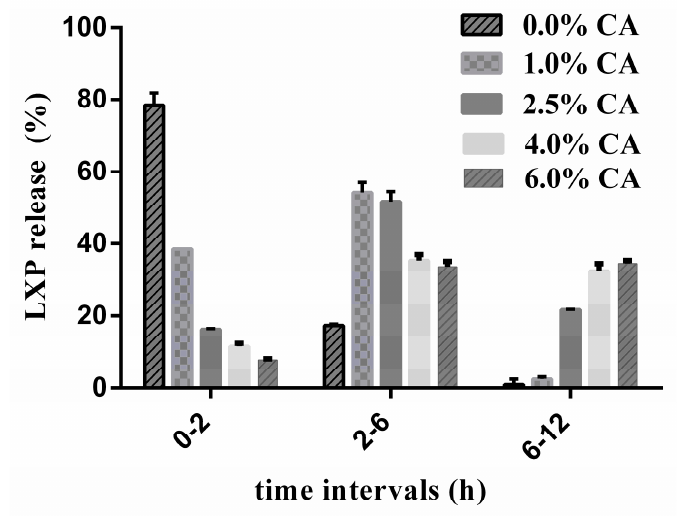
Figure 2. E ff ect of citric acid concentration on the drug release within di ff erent Figure 2. Effect of citric acid concentration on the drug release within different intervals.